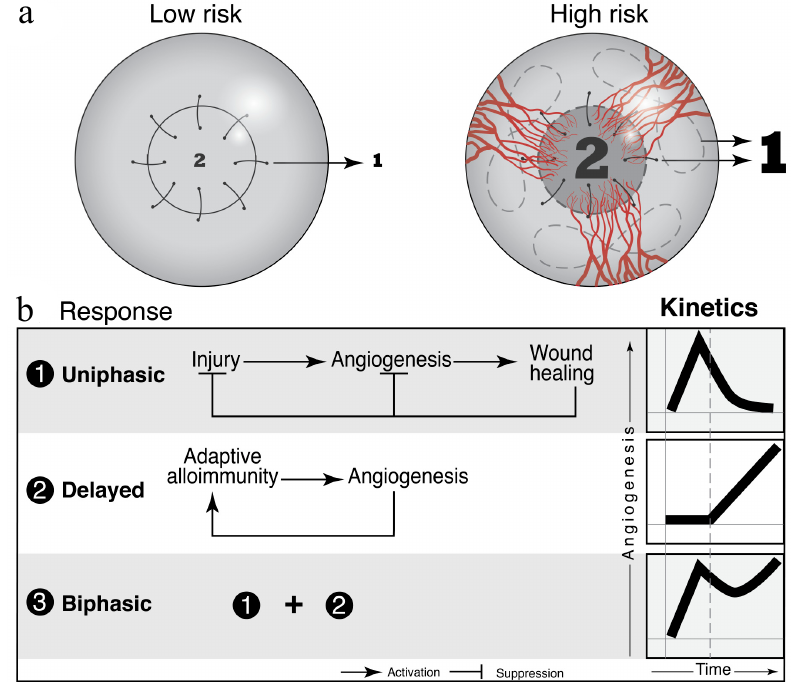
Figure 1. Vascular dynamics in the grafted cornea and in the host bed as predictive and prognostic biomarkers for graft survival in murine models. ( a ) The density of pre-existing vessels correlates with the risk of allograft rejection. “Low risk” and “high risk” murine models are commonly used to study the host response to grafted corneas. ( b ) Wound healing and adaptive immune processes contribute to the angiogenic response to cornea grafts. Figure taken from Azimzade, Y. et al. with permission [43].